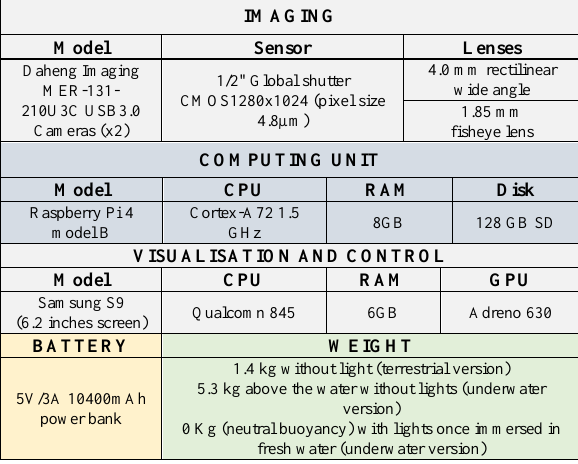
Table 1 . main hardware components and characteristics of GuPho prototypes Figure 4 . Split views of left and right fisheye images with both the domes and checkerboard partially immersed in water to show the absence of significant refractive effects and thus a proper centering procedure of the domes.